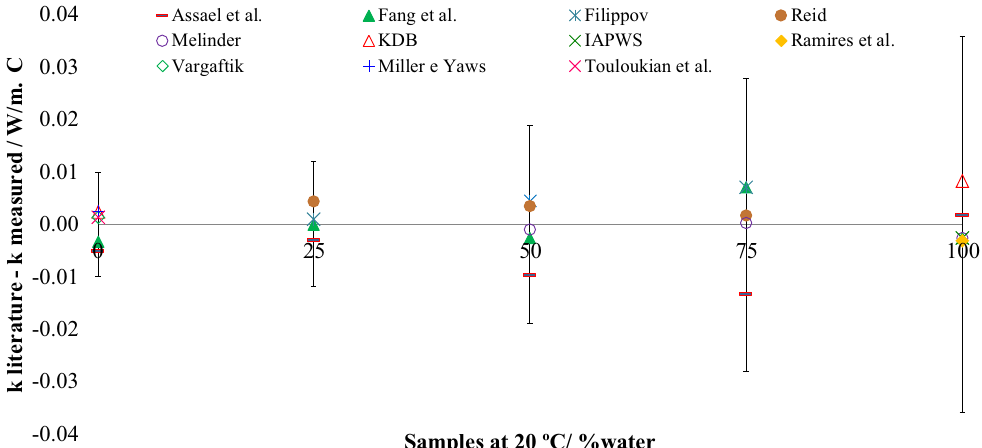
Fig. 3. Differences between literature values and the mean thermal conductivity for sensor